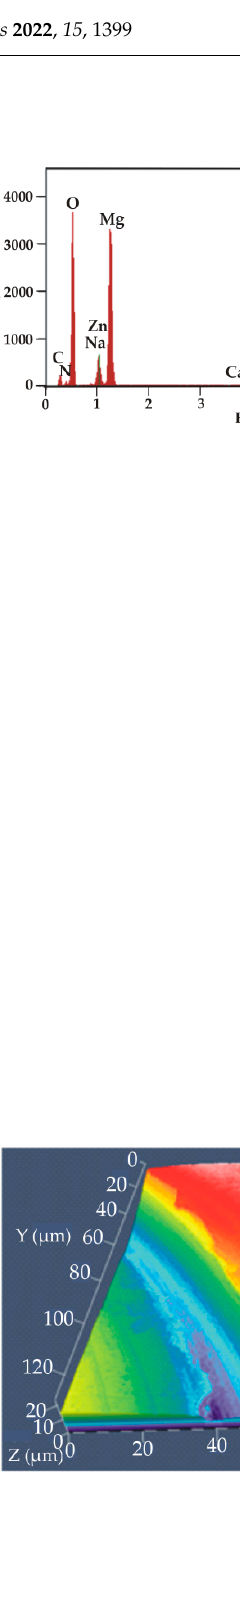
Figure 2. SEM images of surface morphology of conversion coatings deposited on MgCa2Zn1 al- loy: ( a ) casein-free coating (NZ); ( c , e ) casein coating (CN) and MgCa2Zn1Gd3 alloy, respectively: